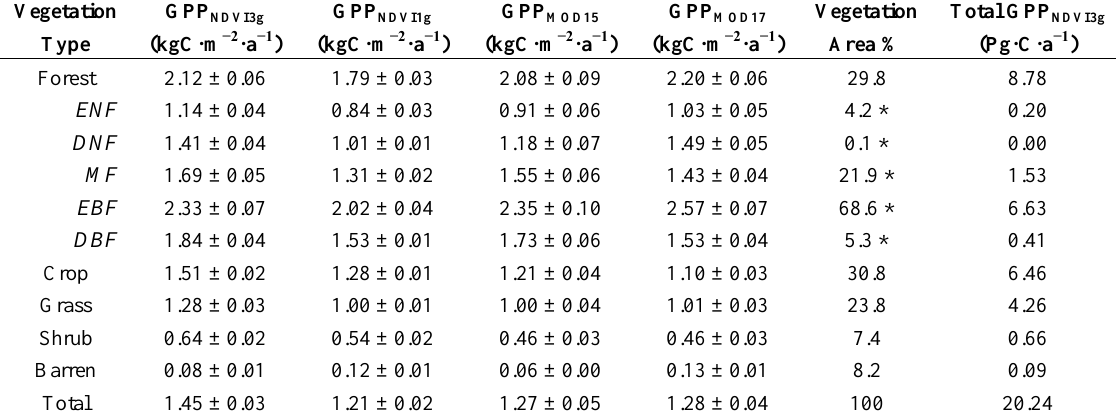
Table 4. The modelled GPP for the main vegetation types in Southeast Asia, from